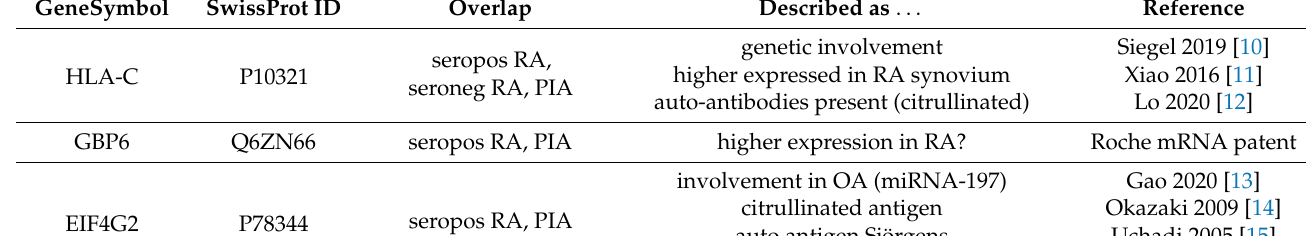
Table 1. Relevance—with respect to the previously described involvements of genes or proteins, of higher reactive DIRAGs overlapping within the identified top 25 pathways of the class—comparisons: seropositive RA vs. seronegative RA (both directions, compare Supplementary Materials Tables S1–S3) and PIA vs. control animals. Described as . .